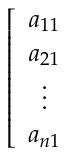
Figure 5. Flowchart of the subgrade performance assessment and prediction: ( a ) Subgrade performance index (SPI) assessment system; ( b ) particle swarm optimization–least squares support vector machine (PSO–LSSVM) model establishment; and ( c ) model